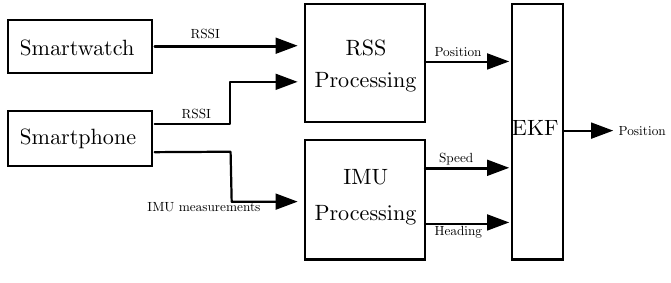
Figure 1. System architecture.